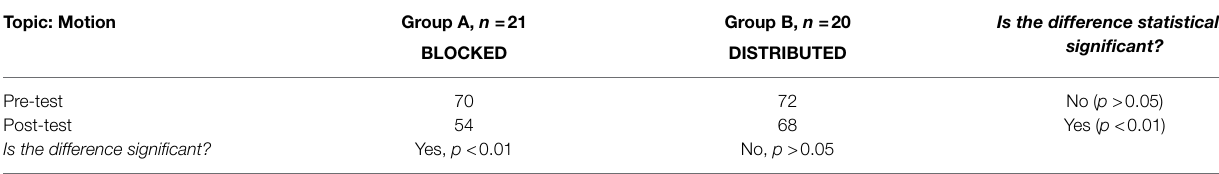
TABLE 4 | Comparing 7th grade science classes using blocked practice vs distributed retrieval practice. Topic: Motion